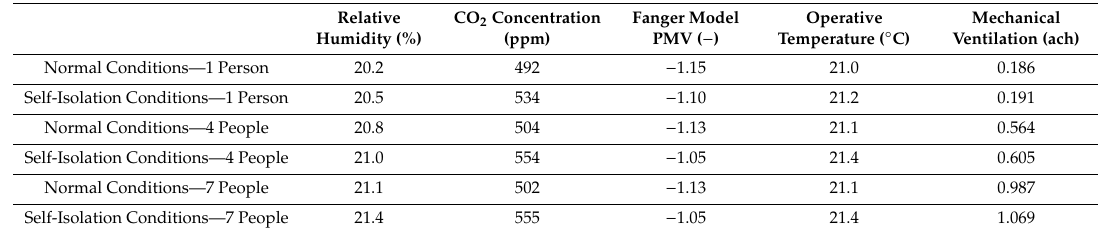
Table 6. Average values of indoor air quality and thermal comfort